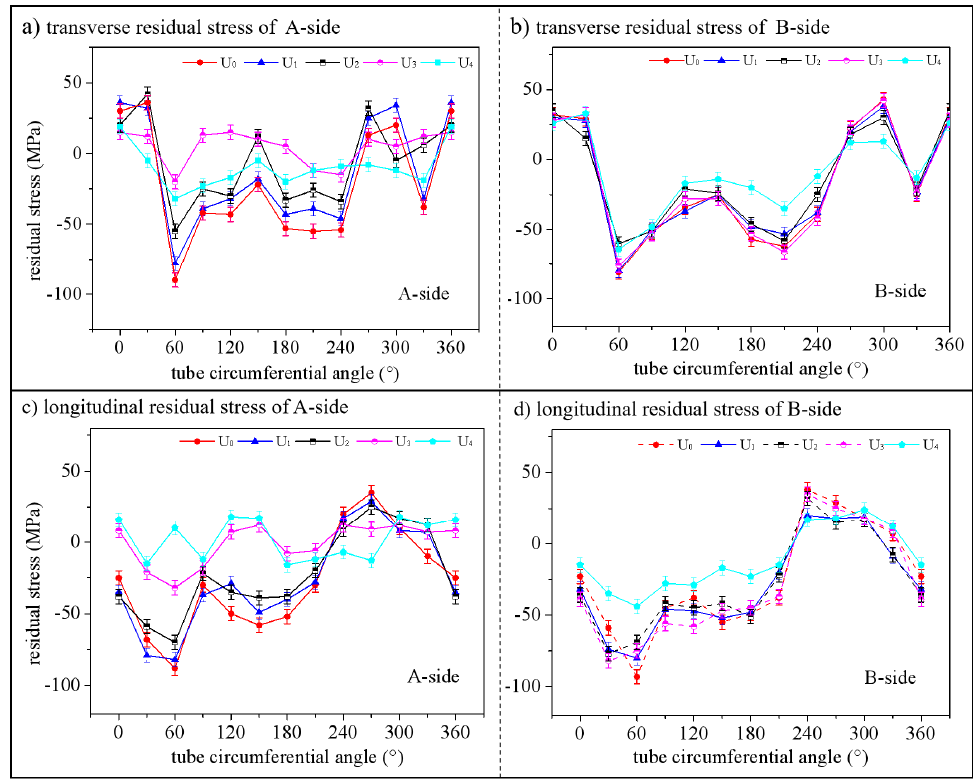
Figure 14. Comparison of residual stress at 20 mm from the center of the weld.